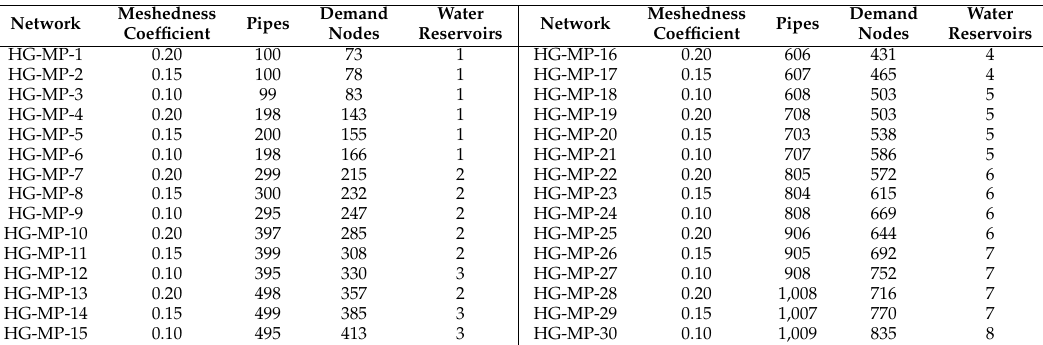
Table 3. Information on the HydroGen instances.